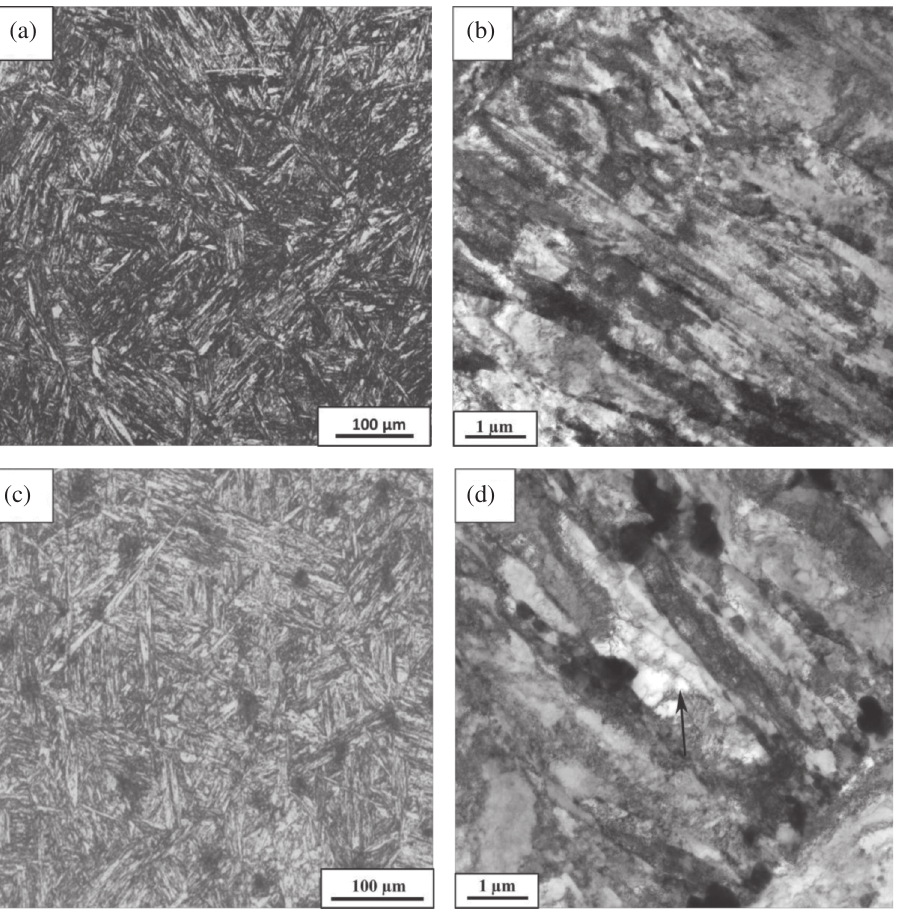
Figure 1: Effect of ageing time at 600°C on microstructure (a) The metallographic structures before ageing (b) The TEM photos before ageing (c) The metallographic structures after ageing (d) The TEM photos after